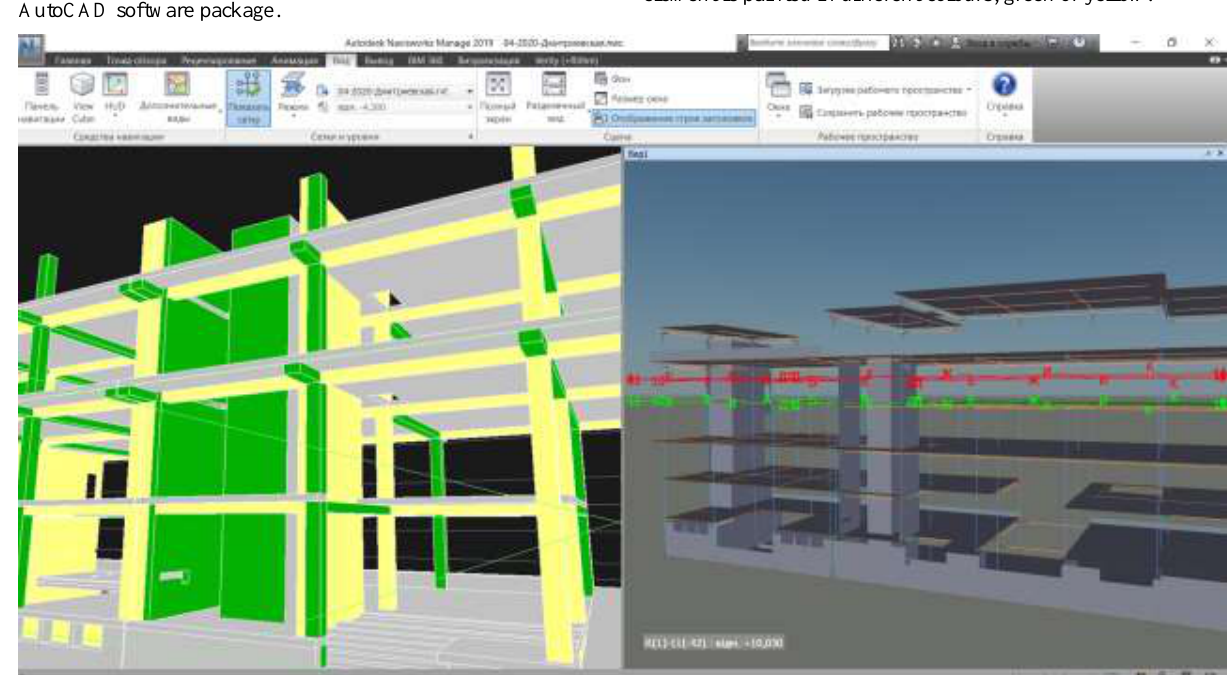
Figure 4 . Structural deformation